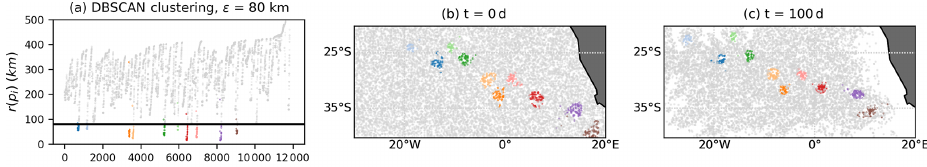
Figure 9. Result of OPTICS applied to the 2D embedding of 12000 randomly selected particles with the classical MDS method (see Fig. 8b; s min = 30). The corresponding spectrum is shown in Fig. B1 in the Appendix, showing that there are two dominant eigenvectors. Grey particles are classified as noise.